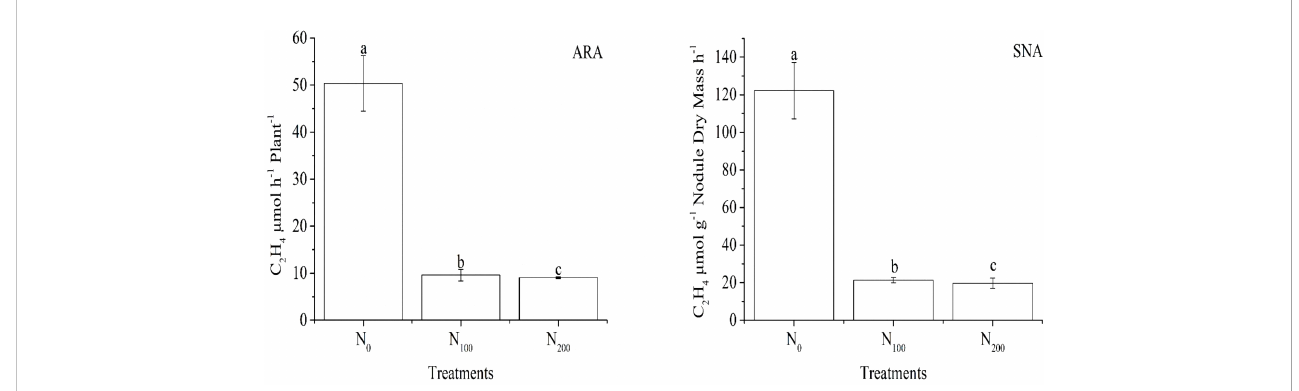
FIGURE 1 Acetylene reduction activity in m mol of ethylene formed per plant per hour (ARA) and speci fi c nitrogenase activity per gram dry weight of nodules per hour (SNA) on the nodulating side of the dual-root soybean plants. The N 0 , N 100 , and N 200 treatments represented the supply of KNO 3 nutrient solution with N concentrations of 0, 100, and 200 mg·L -1 to the non-nodulating side, respectively, with N-free nutrient solution supplied to the nodulating side. Error bars are the standard error of three replicates. Different lowercase letters indicate a signi fi cant difference between the treatments at the 5%